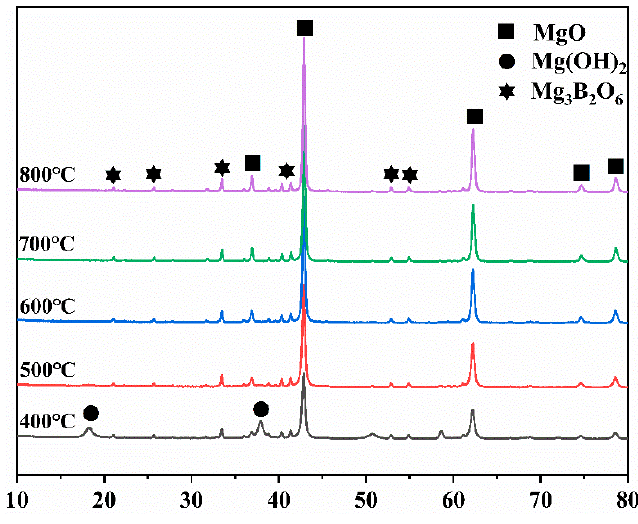
Figure 5. XRD patterns of magnesium residue calcined at different temperatures. Table 3. Mineral phase composition of the magnesium residue calcined at different temperatures.